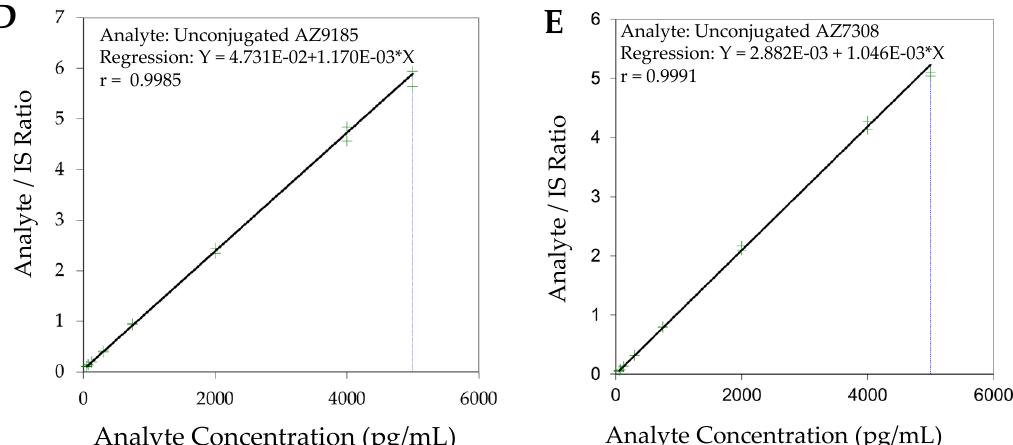
Figure 4. Representative calibration standard curves ( A ). Total ADC (MEDI4276) ( B ). Total antibody (MEDI4276) ( C ). Total ADC (MEDI1498) ( D ). Unconjugated AZ13599185 (AZ9185) ( E ). Unconjugated AZ13687308